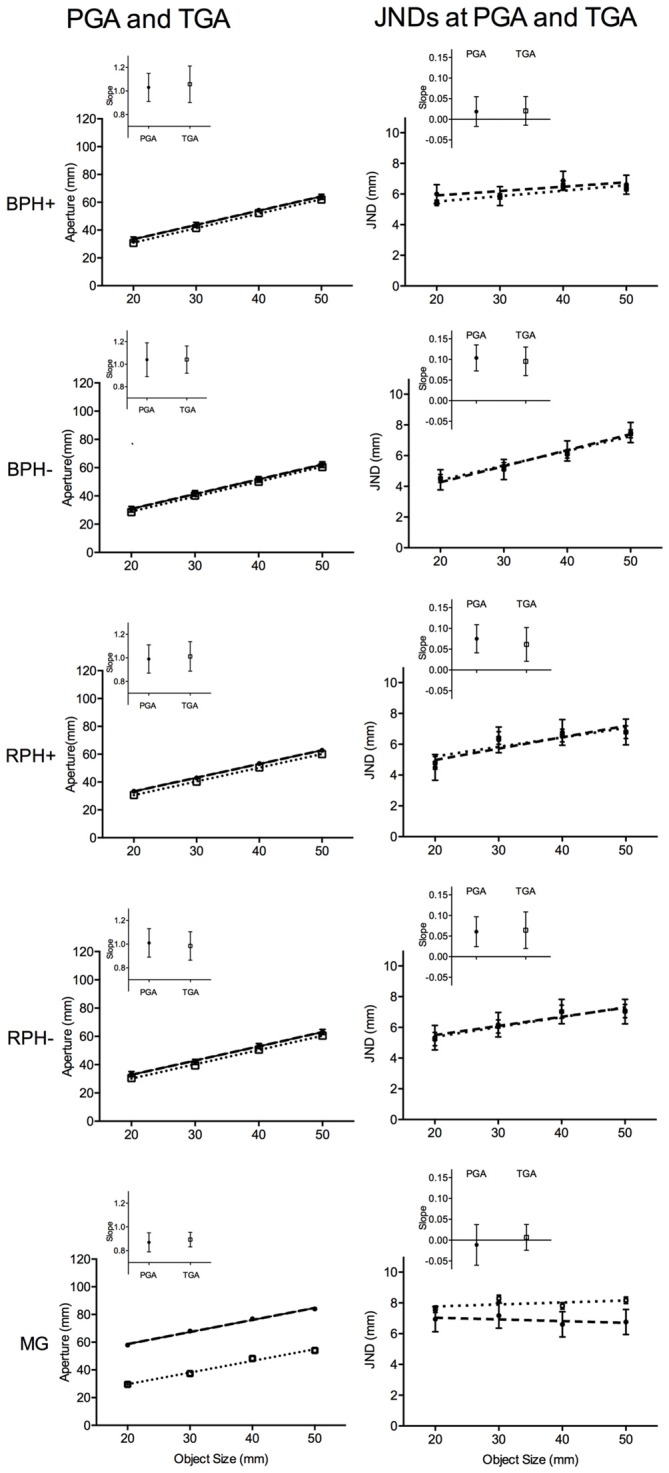
The left panels present mean peak grip aperture (PGA in mm; see closed circle symbols and dashed regression line) and terminal grip aperture (TGA in mm; see open square symbols and dotted regression line) and the right panels depict just-noticeable-difference (JND in mm) values computed at PGA (see closed circle symbols and dashed regression line) and TGA (see open square symbols and dotted regression line) for: (1) blocked feedback schedule pantomime-grasping trials performed with (BPH+) and (2) without (BPH−) haptic feedback, and (3) random feedback schedule pantomime-grasping trials performed with (RPH+) and (4) without
(RPH−) haptic feedback, and (5) MG trials. Error bars represent 95% within-participants confidence intervals as a function of the mean-squared error term for object size computed separately for each trial-type (Loftus and Masson, 1994). Note: for the PGA and TGA panels the size of the error bars is less than the width of the symbol depicting the mean value, as well, for all pantomime-grasp trial-types a significant degree of overlap exists between PGA and TGA values. The inset panels represent the mean participant-specific slope relating PGA and TGA to object size and JNDs (computed separately at PGA and TGA) to object size. Error bars represent 95% between-participant confidence intervals and the absence of overlap between a confidence interval and the horizontal line indicates that the slope reliably differed from zero, and is a result that can be interpreted inclusive to a test of the null hypothesis (Cumming, 2013).